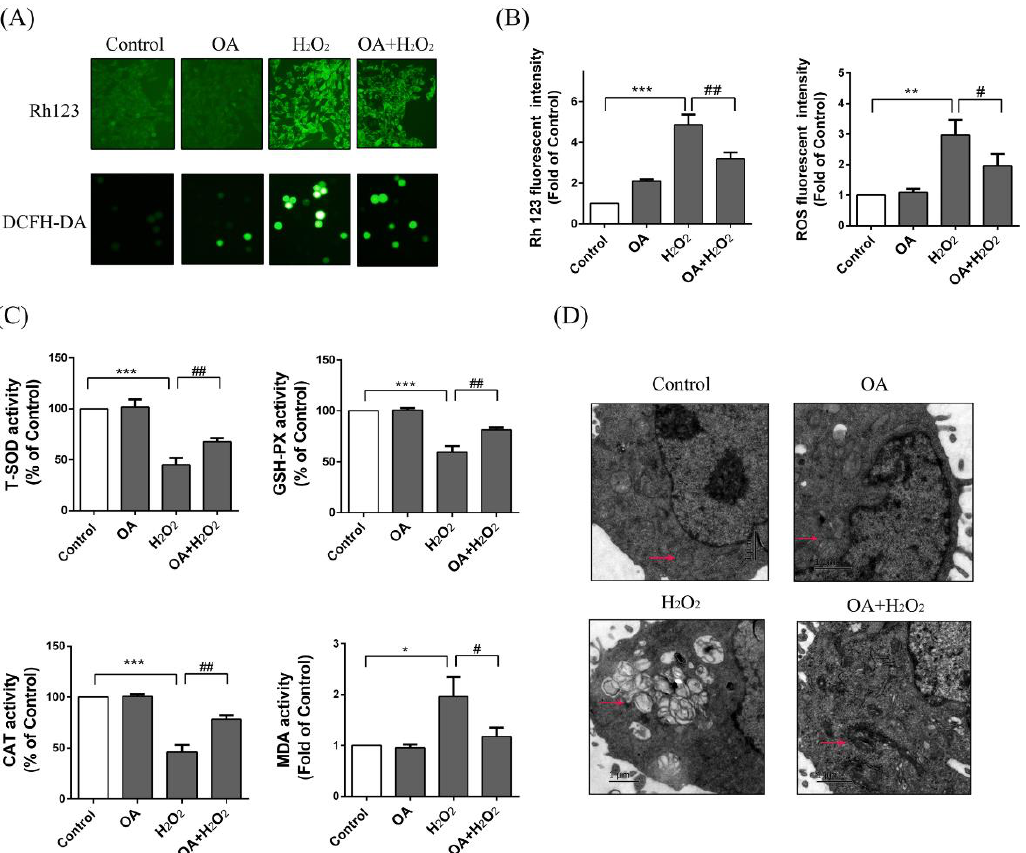
Figure 3. Effects of OA on reactive oxygen species (ROS) and morphology of mitochondria. ( A ) The membrane potential changes and ROS production were detected by Rh123 and DCFH-DA probes respectively by fluorescence microscope (200 × ). Groups were as described in “Methods: Cell line and Reagents”; ( B ) The fluorescence intensity of Rh123 and ROS was measured by FCM; ( C ) The activity of SOD, GSH-PX, CAT, MDA. Groups were as described in “Methods: Cell line and Reagents”; ( D ) The morphology of mitochondria by transmission electron microscopy. Groups were as described in “Methods: Cell line and Reagents”. Pink arrows point to mitochondria. The experiments were repeated at least three times. The results were presented as the mean ± SD. * p < 0.05, ** p < 0.01, *** p < 0.001 compared with the control group and # p < 0.05 and ## p < 0.01 compared with the H 2 O 2 group.